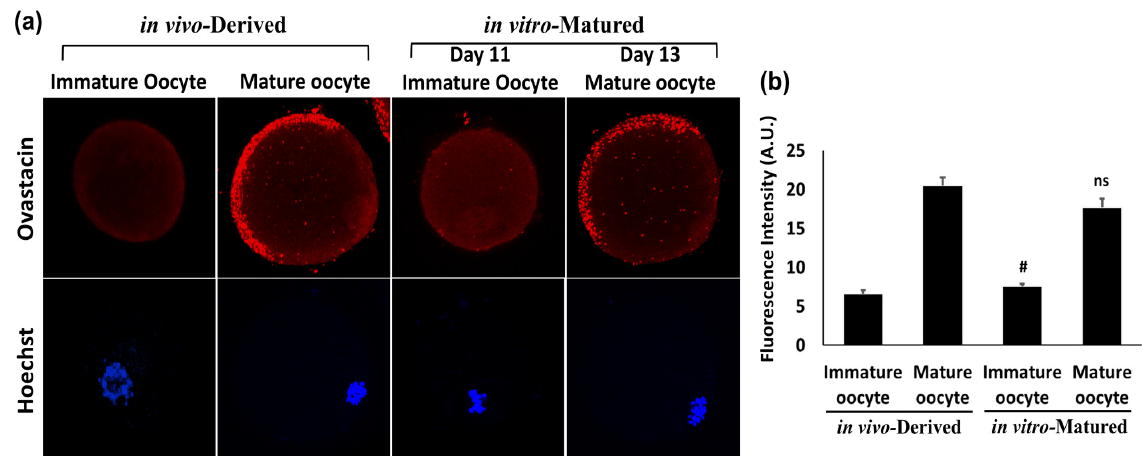
Figure 5. Authentication of an in vitro-matured oocyte obtained from a GFP electroporated preantral follicle through the immuno-localization of the oocyte maturation marker ovastacin. ( a ) Immature and mature oocytes derived in vivo were compared with in vitro-matured oocyte collected on day 11 and 13 from the preantral follicle after the electroporation with GFP, respectively. Ovastacin is known to localize throughout the cytoplasm of the immature mouse oocytes (germinal vesicle stage) and mostly concentrate at the cell periphery, whereas in MII mature oocytes, it localizes mainly in the microvillar domain of the oolemma. The expression pattern of ovastacin (red) was found to be similar for both the corresponding stages; in vivo-derived oocytes with in vitro-cultured oocytes from transfected preantral follicles. ( b ) Comparison of fluorescent intensities between in vivo derived vs. in vivo matured groups. # and ns indicate a non-significant difference in in vivo-derived vs. in vitro-matured groups, respectively. Original magnification of photomicrographs was ×400.